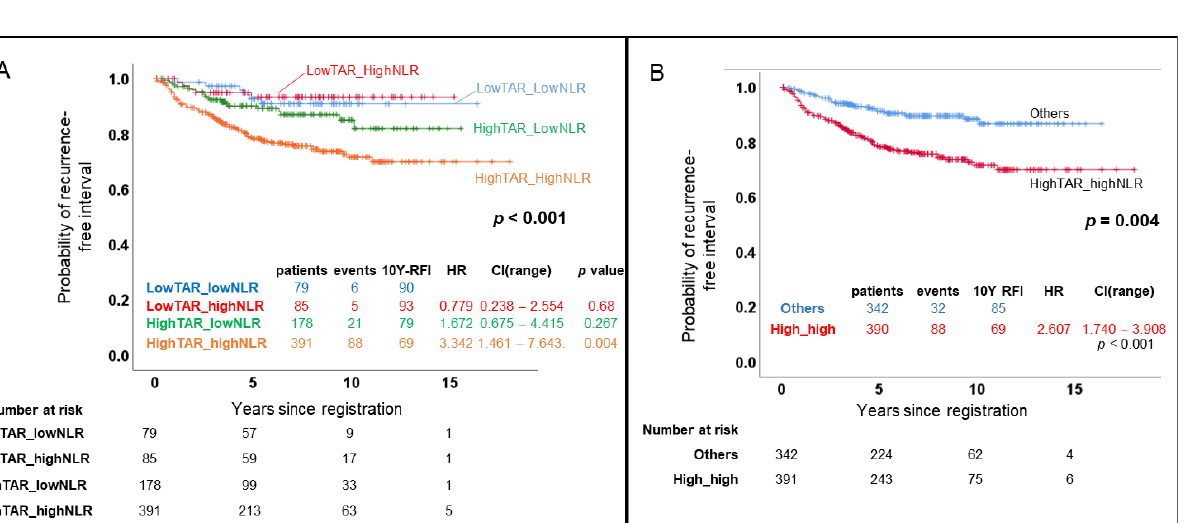
High-high, patients with TAR > 0.27 and NLR > 1.61; LN, lymph node; ER, estrogen receptor; PR, progesterone receptor; HER2, human epidermal growth factor receptor 2. The high-high group showed a significantly worse RFI than the others group (HR, 2.607; CI, 1.740 − 3.908; p < 0.001) (Figure